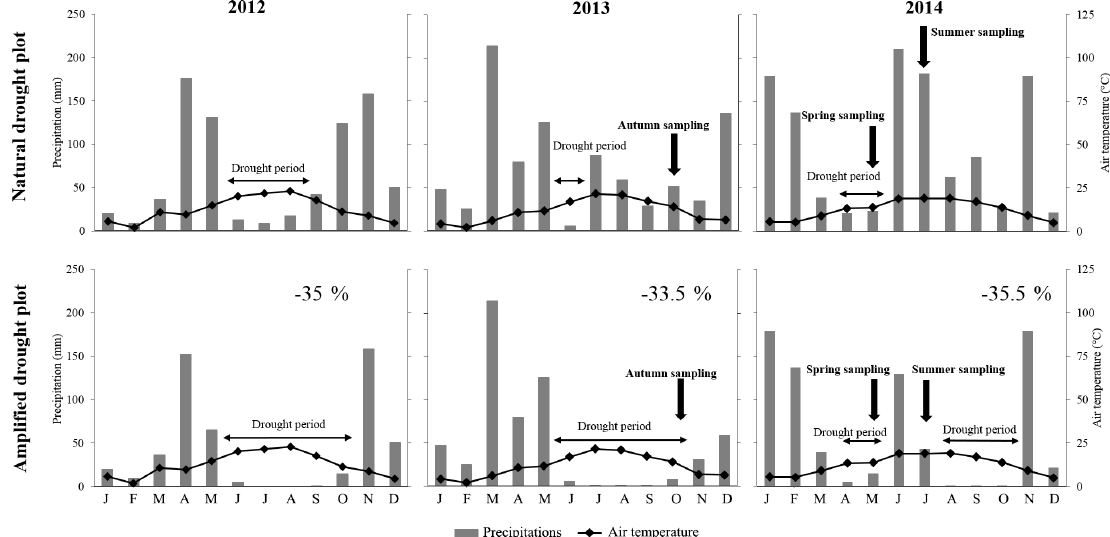
Figure 1. Ombrothermic diagram for natural and amplified drought in 2012, 2013 and 2014. Bars represent mean monthly precipitation (mm) and curves represent mean monthly temperature ( ◦ C). On each amplified drought graph, the percentage represents the proportion of excluded rain compared to the natural drought